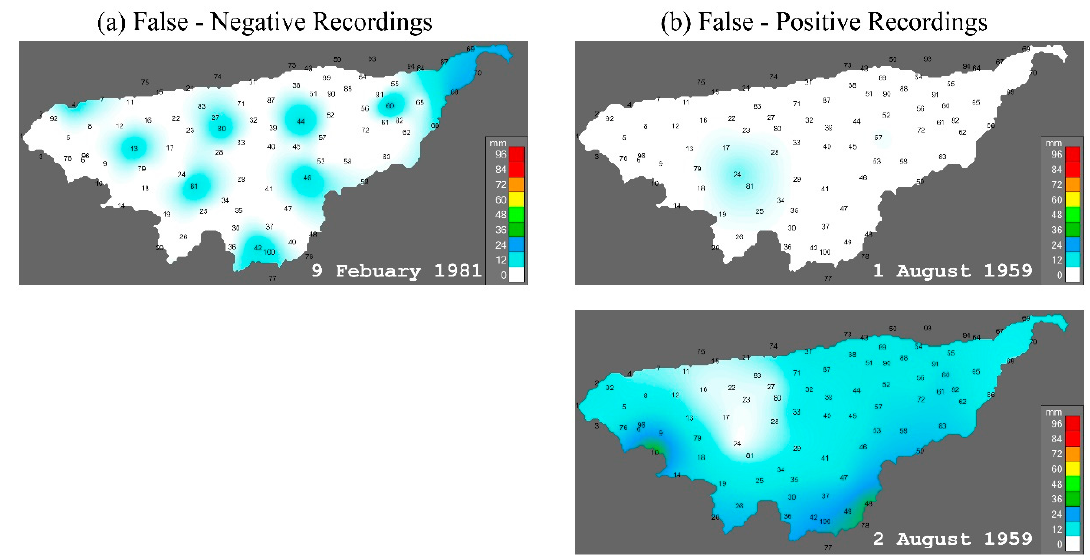
Figure 5. Rainfall errors identified with the aid of rainfall maps, ( a ) False-Negative recording error that shows zero rainfall is a large portion of the watershed while in reality those gauges were turned off and ( b ) False-Positive recording errors: a closer look at inconsistent and abrupt changes in interpolation field showed errors resulting from date coding.